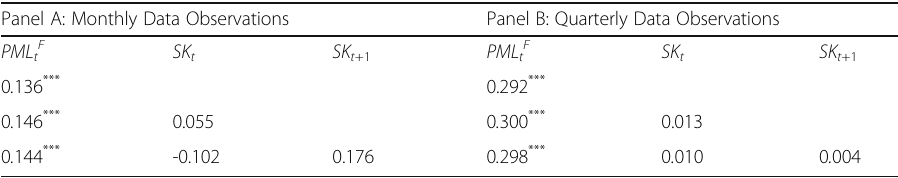
Table 17 Regression with Skewness Controlled Panel A: Monthly Data Observations Panel B: Quarterly Data